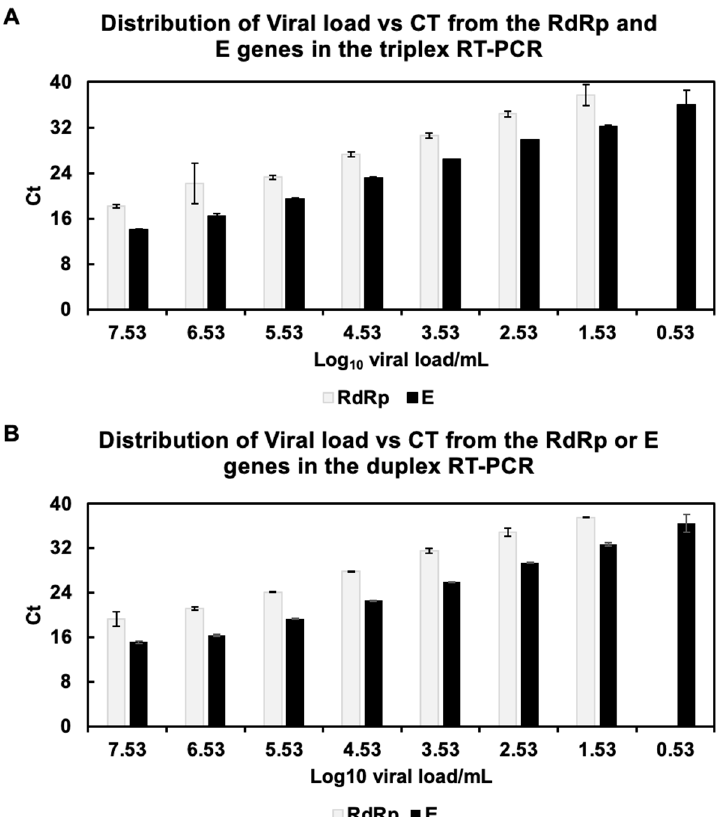
Figure 2. Limit of detection of RdRp and E genes in ( A ) duplex RT-PCR or ( B ) triplex RT-PCR. The E gene shows more sensitivity than the RdRp gene, both in the duplex and triplex assays. Average Ct values and SD from triplicate reactions are shown.